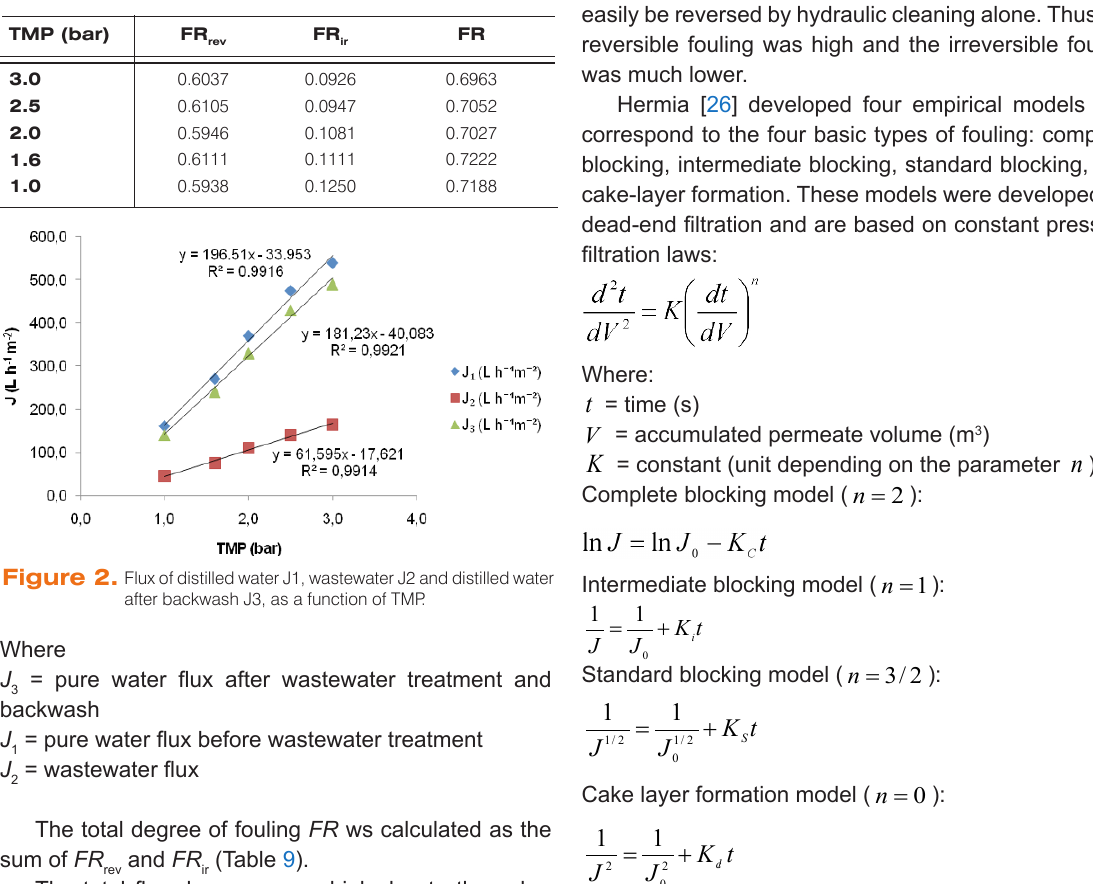
Table 9. The degree of reversible, irreversible and total fouling.